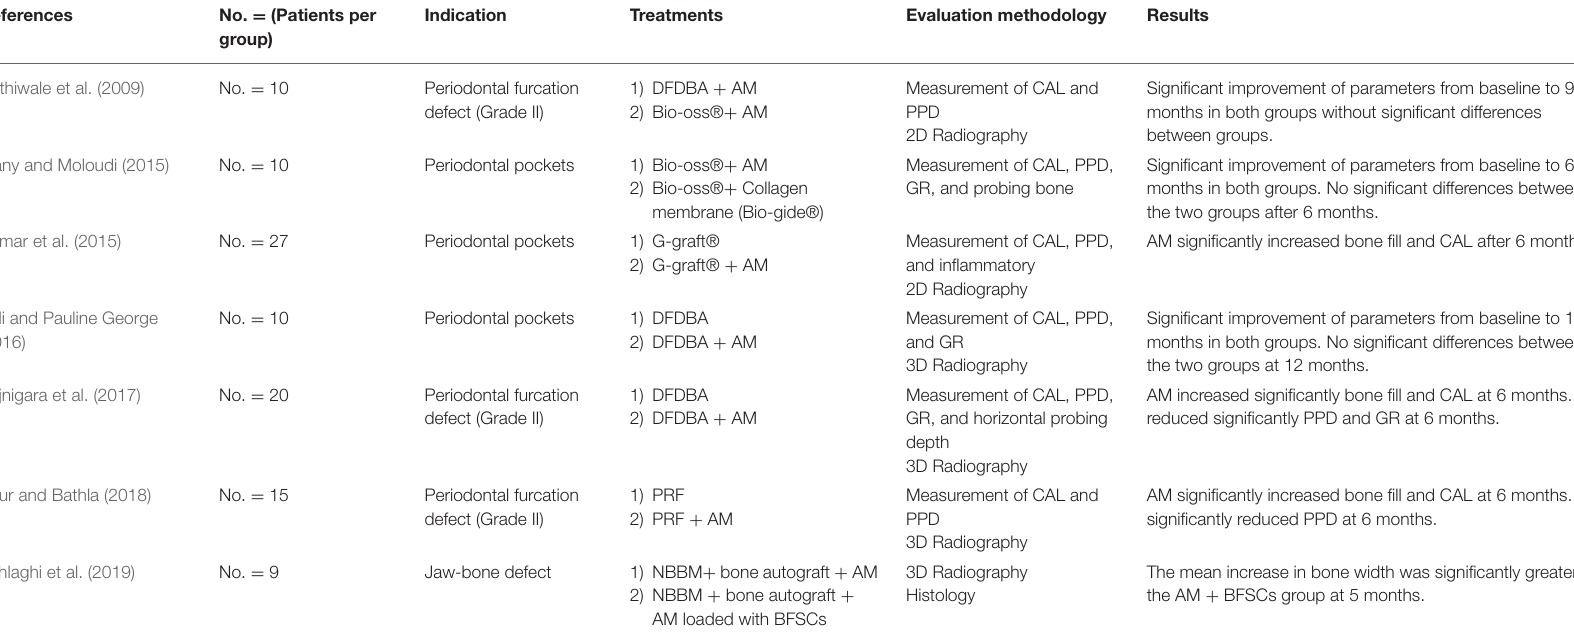
TABLE 4 | Clinical studies using amniotic membrane to guide bone